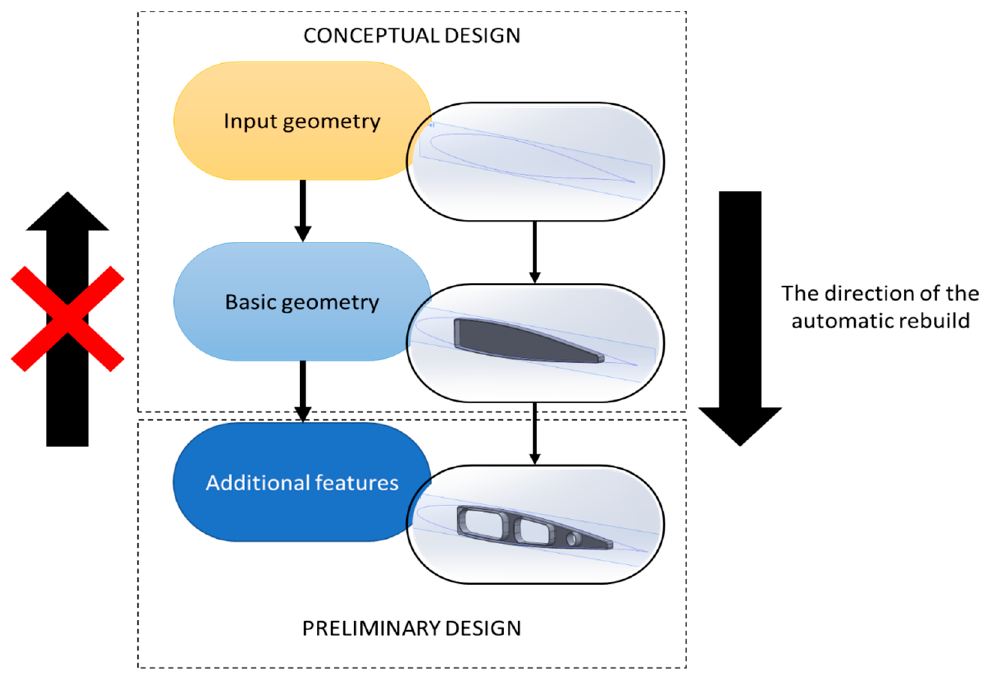
Figure 6. The hierarchical order of automatic rebuilding.